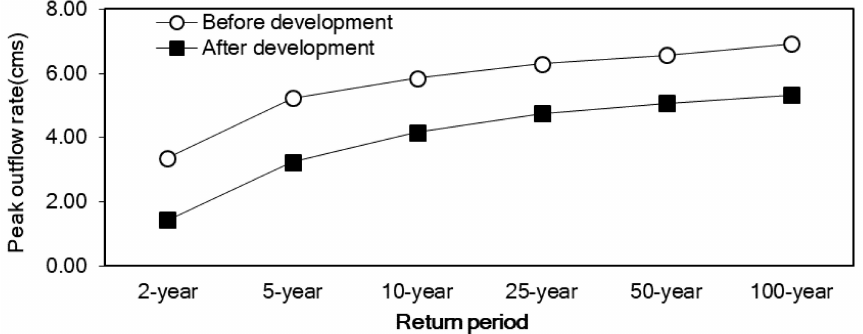
The peak outflow rate comparison of various return periods before and after land